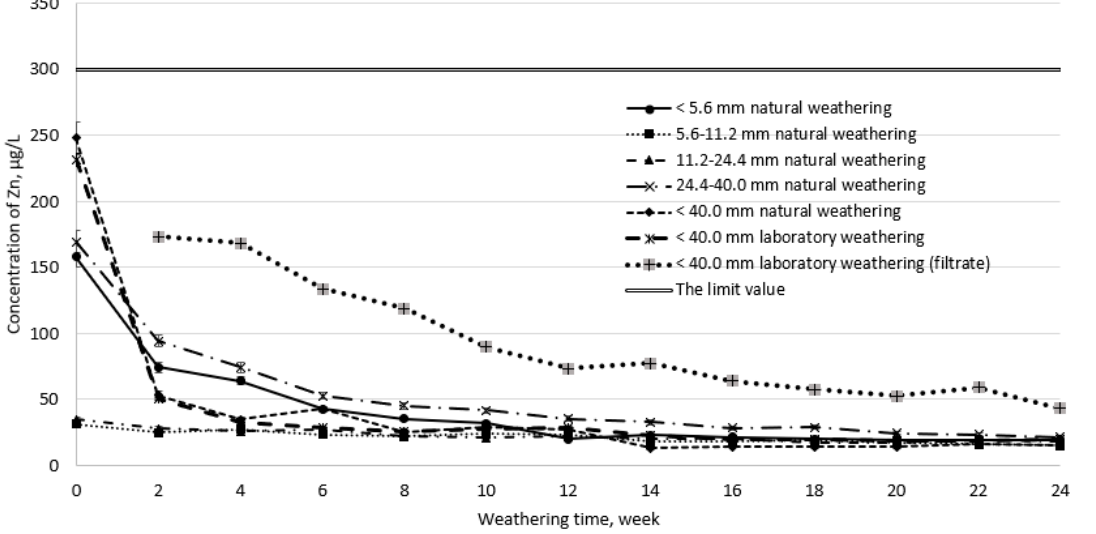
Figure 11. Concentration of zinc (Zn) in different fractions of bottom ash eluate and leachate during natural weathering and laboratory aging.